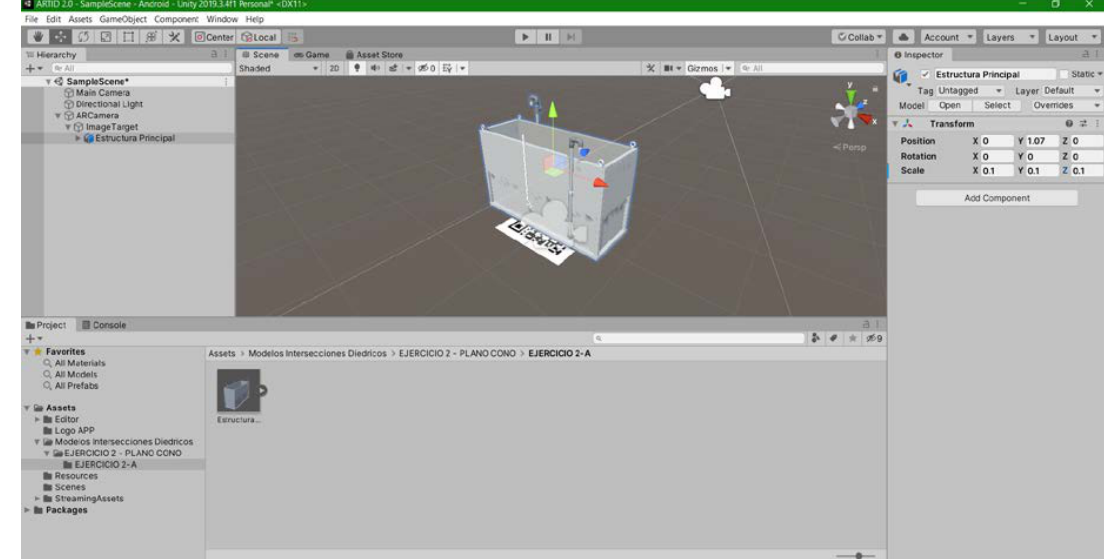
Figure 6. Screenshot of the Unity software.